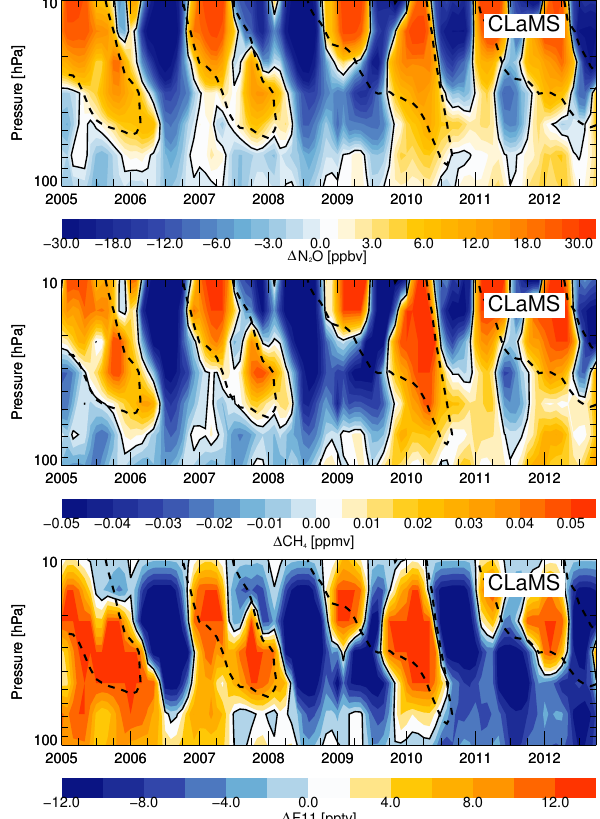
Figure 8. The anomaly pattern of tropical ( ± 15 ◦ ) tracer fields as simulated by CLaMS for the time period 1 January 2005 to 31 October 2012. Top panel shows N 2 O, middle panel CH 4 , and bot- tom panel CCl 3 F (CFC-11). Dashed contours ( − 15m s − 1 wind line from ERA-Interim) illustrate the easterly phase of the QBO.